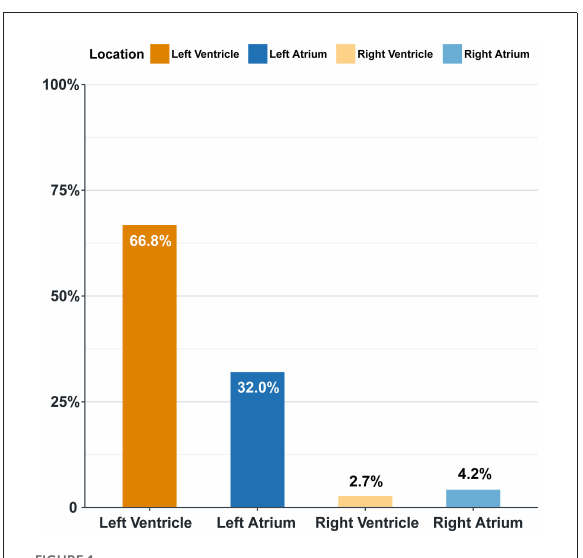
FIGURE1 Intracardiac location features in heart failure patients